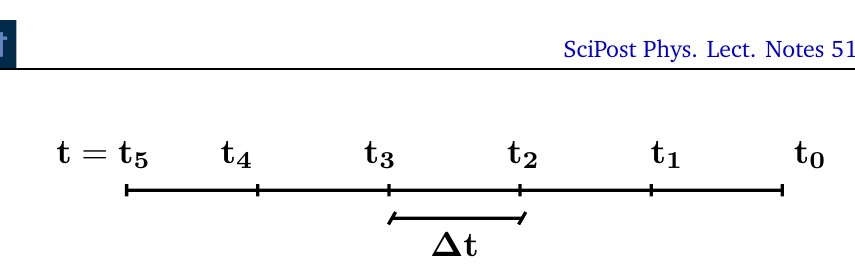
Figure 2: Time-slicing adopted in the discretization of the path ordered exponential of Eq. (14), for N = 5. Note that time increases to the